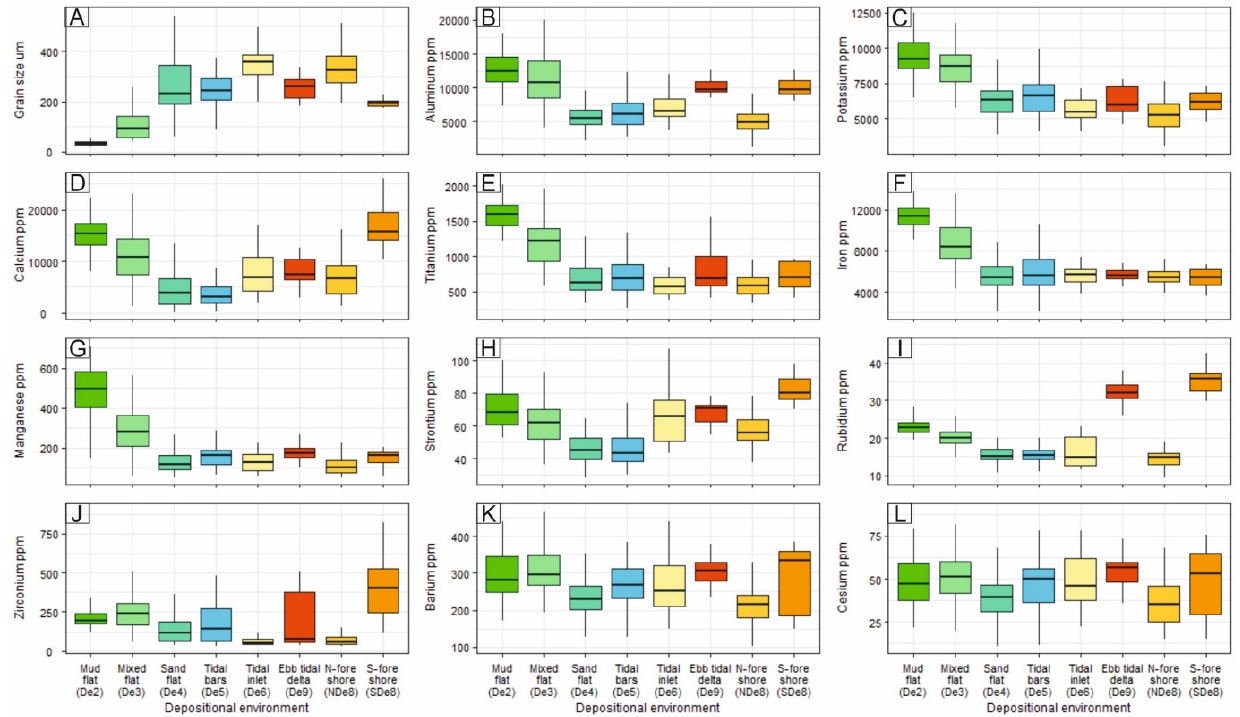
Figure 5. Boxplots for texture and element concentrations as a function of the Ravenglass Estuary sub-depositional environment: ( A ) grain size (mm), ( B ) aluminium, ( C ) potassium, ( D ) calcium, ( E ) titanium, ( F ) iron, ( G ) manganese, ( H ) strontium, ( I ) rubidium, ( J ) zirconium, ( K ) barium, ( L ) caesium. Boxplots contain the median and upper and lower quartile ranges. Outliers are defined as > (or <) 1.5-times the interquartile range, above the upper and below the lower quartiles. Element concentrations vary greatly between different sub-depositional environments; for example, Ti and Fe concentrations are highest in the mud flat, and Rb and Sr concentrations are highest in the southern foreshore. Overall, the element concentrations in the sand-dominated sub-depositional environments show weak variability, potentially because of quartz